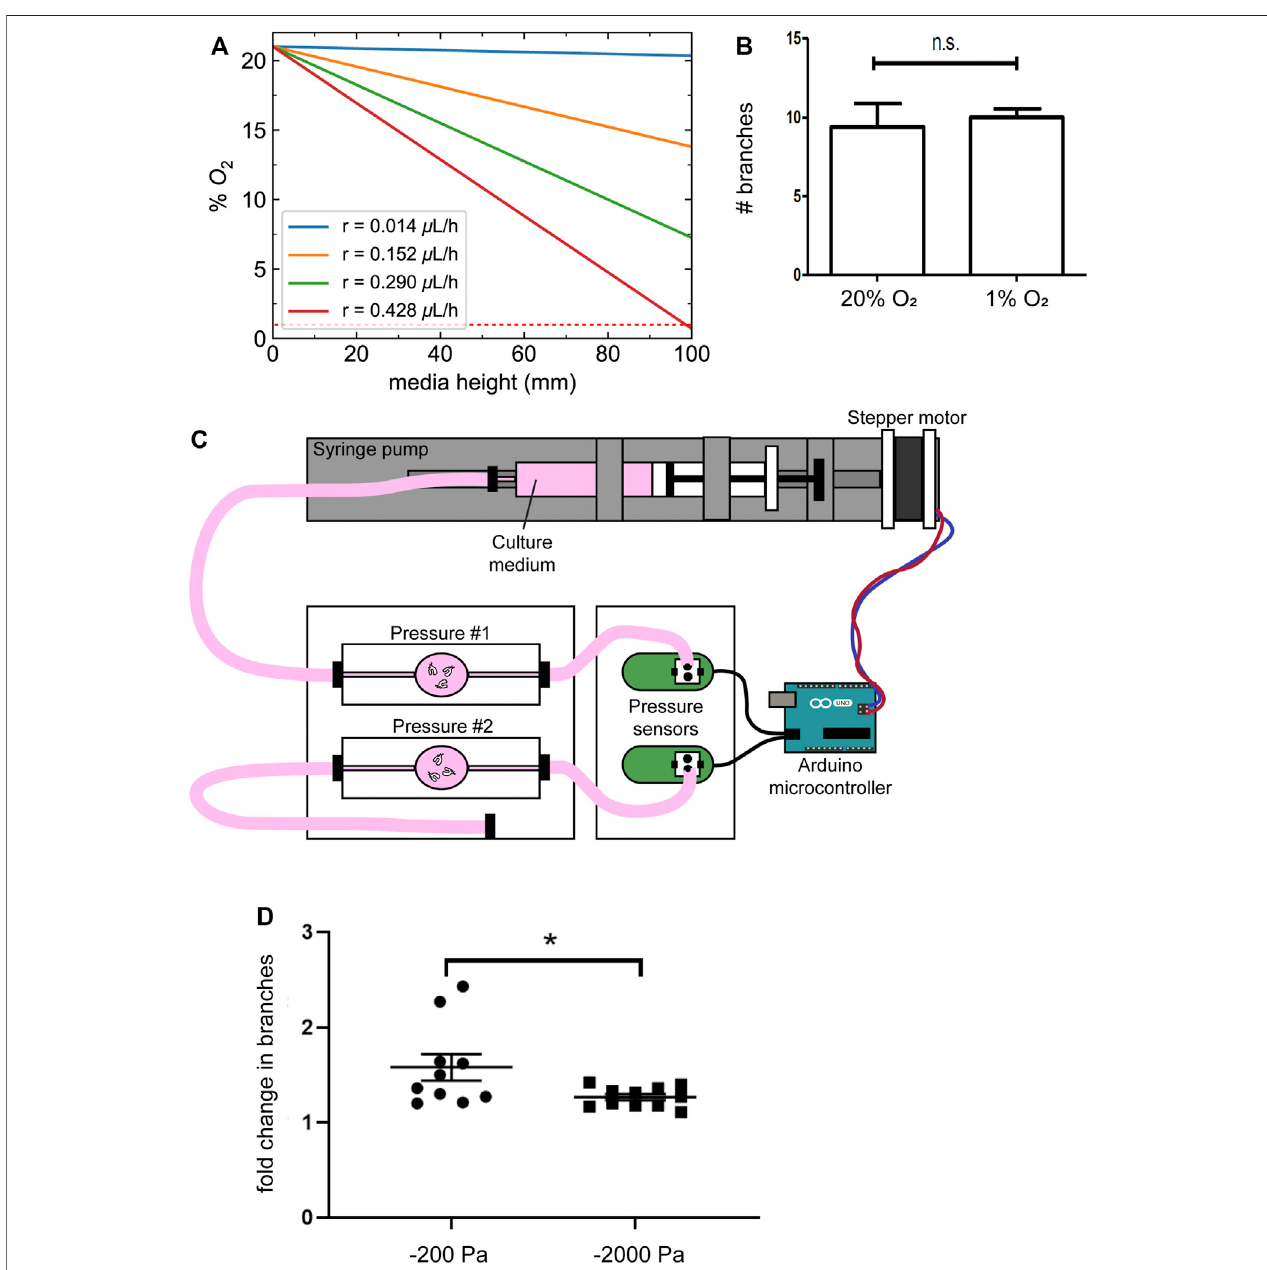
FIGURE 4 | Changes in oxygen tension do not account for the effects of negative transpulmonary pressure on airway branching. (A) Calculated oxygen concentrationsasafunctionofdepthwithinthecolumnofmediaabovetheexplants,atdifferentmagnitudesofoxygenconsumptionrate(r).Dottedredlineindicates1% O 2 . (B) Number of branches formed after 24 h of culture of lung explants under normoxic or hypoxic conditions. (C) Schematic of culture device used to apply transpulmonary pressure in a constant volume, constant height setting. (D) Fold-change in the number of branches in lung explants cultured for 24 h under the conditions shown in (C) . Scale bars, 250